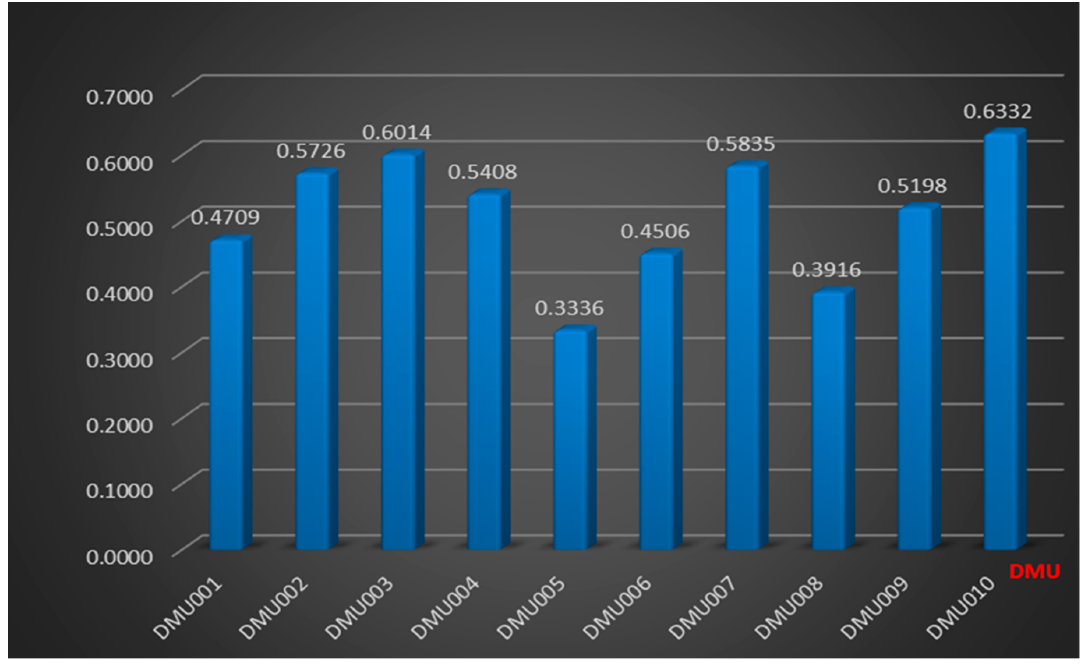
Figure 6. Final ranking score.